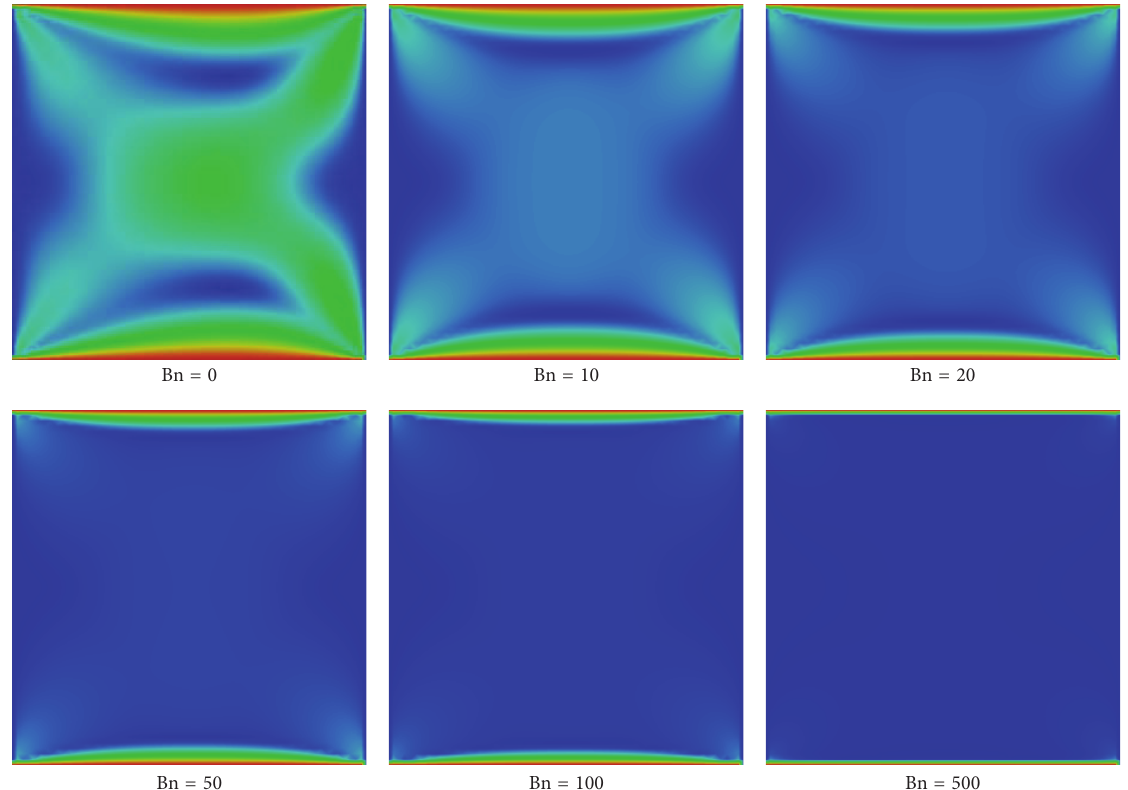
Figure 7: Velocity profiles for double lid driven cavity at different values of Bingham number Bn.